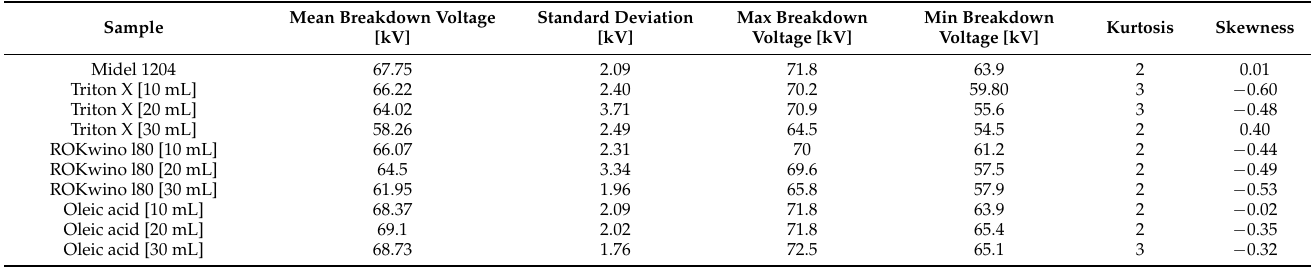
Table 3. Characteristic values of concentrations distribution for all